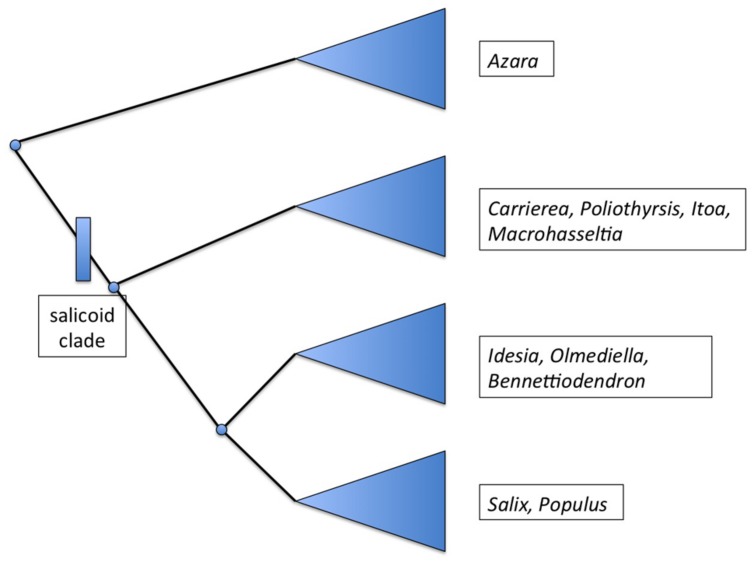
Summary phylogenetic diagram showing the major groupings within the salicoid clade, after Alford et al. (2009).